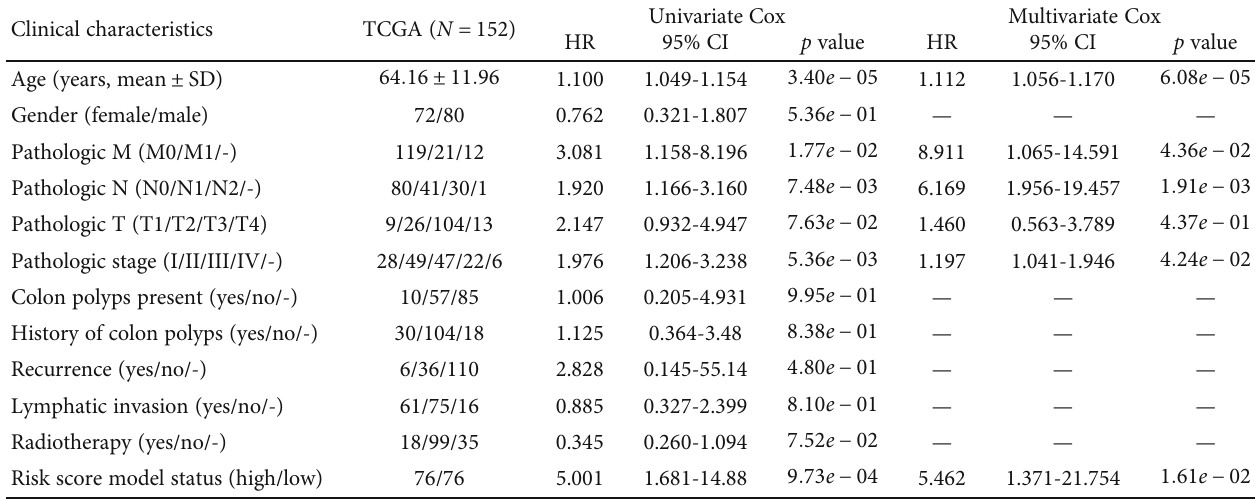
Table 3: Univariate and multivariate Cox regression of the clinical features and risk score. Clinical